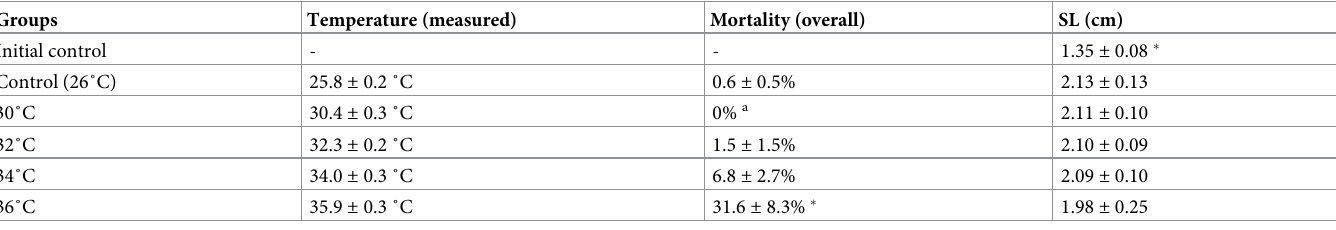
Except for the initial control, the standard length (SL) indicates the length of the fish at week 4 (Mean ± SD; � p <